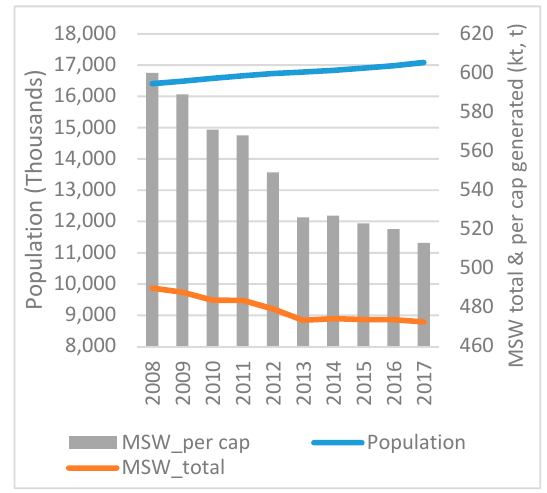
Figure 37. Population and MSW production in The Netherlands 2008–2017 (European Statistics 2019a, 2019c).